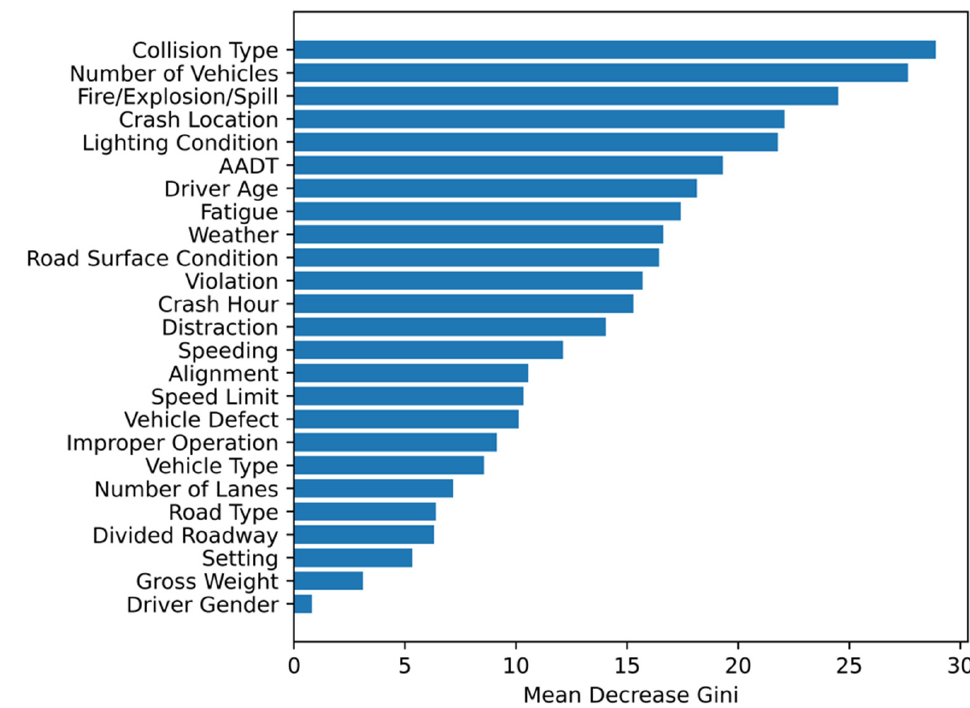
Figure 2. Variable importance ranking using random forests.